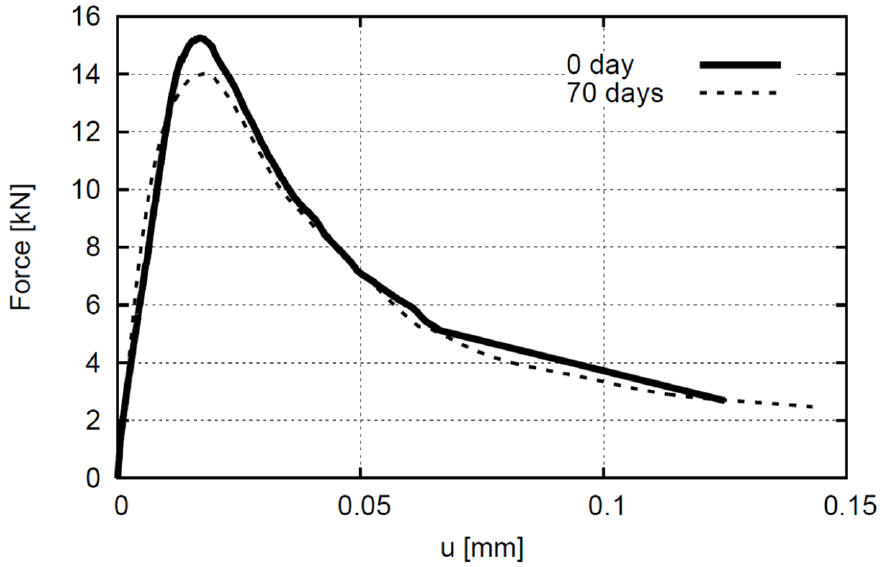
Figure 9. Experimental pull-out vertical force-displacement diagrams for reinforced concrete: without corrosion and after 70 days of accelerated corrosion test. 3D X-ray micro-CT investigations revealed that concrete cracking was similar for both cases (Figures 10 and 11). The failure occurred due to the presence of radial cracks with a maximum width equal to approximately 0.25 mm.